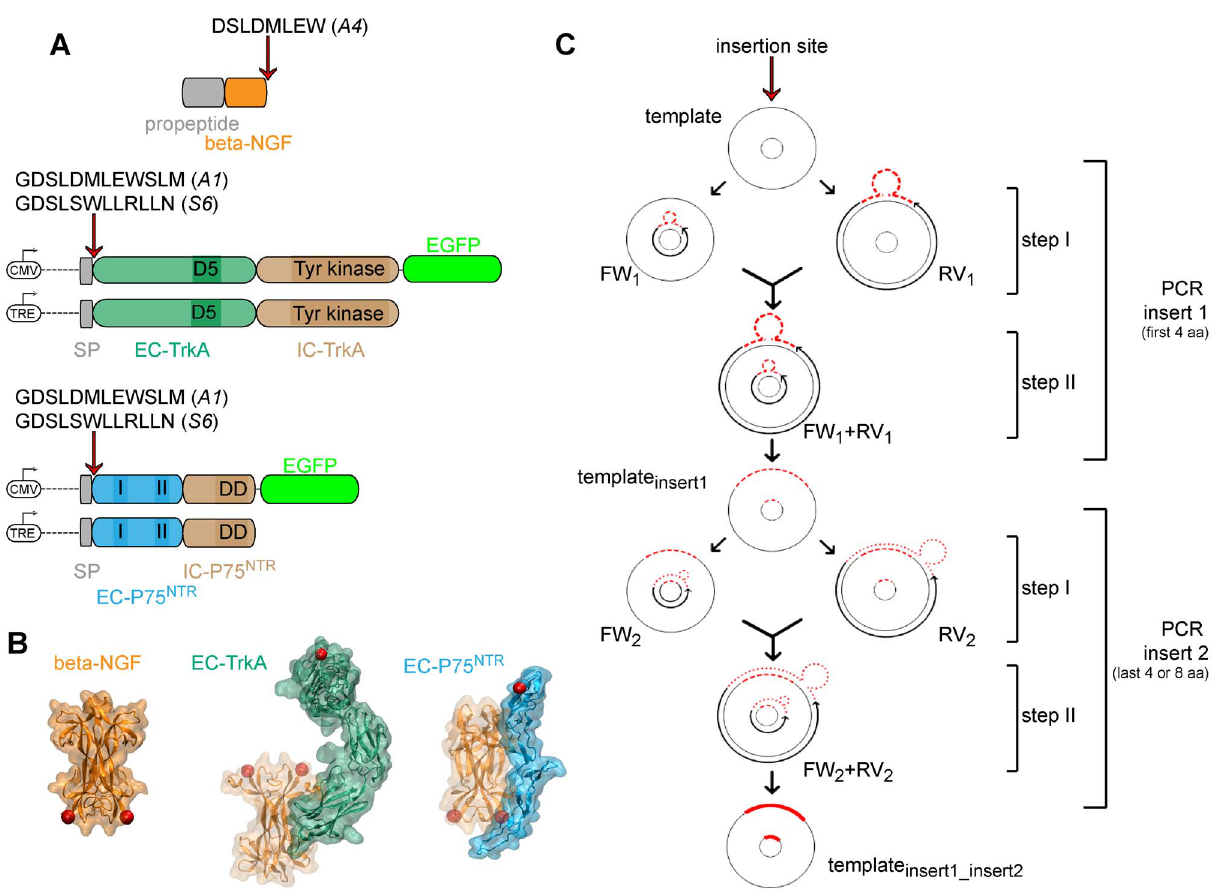
Figure 1. Schematic overview of the insertional mutagenesis method. A ) Cartoon depicting NGF, TrkA, and P75NTR constructs prepared for this study. The site of tag insertion is indicated in each case by a red arrow. On top of the arrow the complete amino acidic tag sequence is reported. The promoters used for expression of the receptors are depicted upstream each receptor construct. On the extracellular domain of the receptors, sites of interaction with NGF are highlighted; on the intracellular domain of the receptors, sites of receptor activity are highlighted. Abbreviations: CMV 5 Cytomegalovirus promoter; TRE 5 Tet-Responsive-Element promoter; SP 5 signal peptide; EC 5 extracellular domain; IC 5 intracellular domain; D5 5 proximal immunoglobulin-like domain; I 5 NGF-interaction site 1; II 5 NGF-interaction site 2; DD 5 death domain. B ) Crystal structure of NGF (left; PBD. n.1BET), NGF-TrkA (EC) (middle; PBD. n.2IFG), NGF-P75NTR(EC) (right; PBD. n.1SG1). The color code is the same as in panel A. Red spots highlight the sites of tag insertion in each protein. C ) Scheme of the insertional mutagenesis procedure used in this study. Details are provided in Text S1.